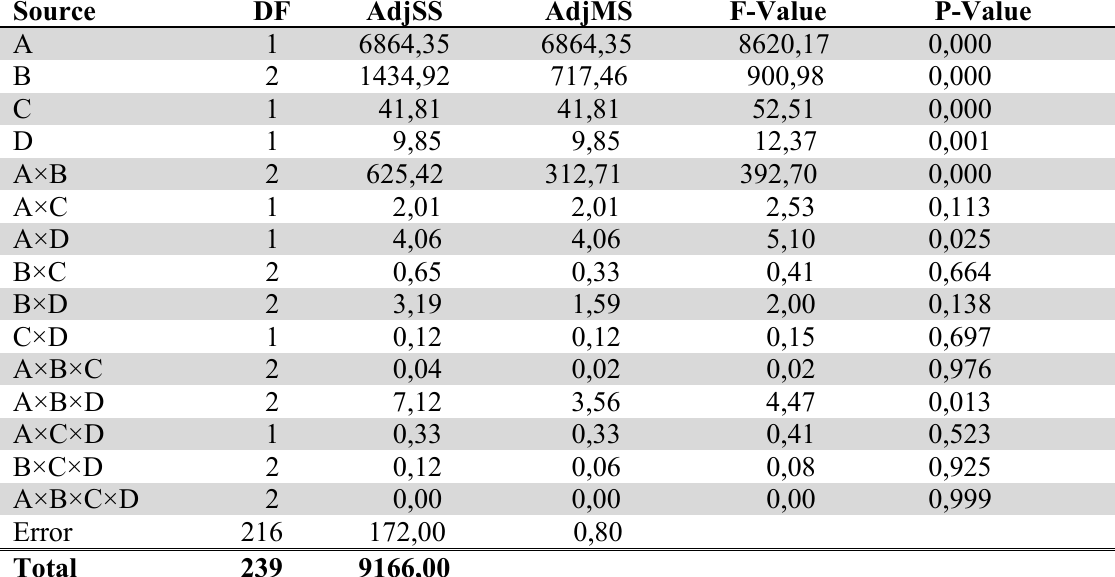
Table 10 Analysis of Variance of ration